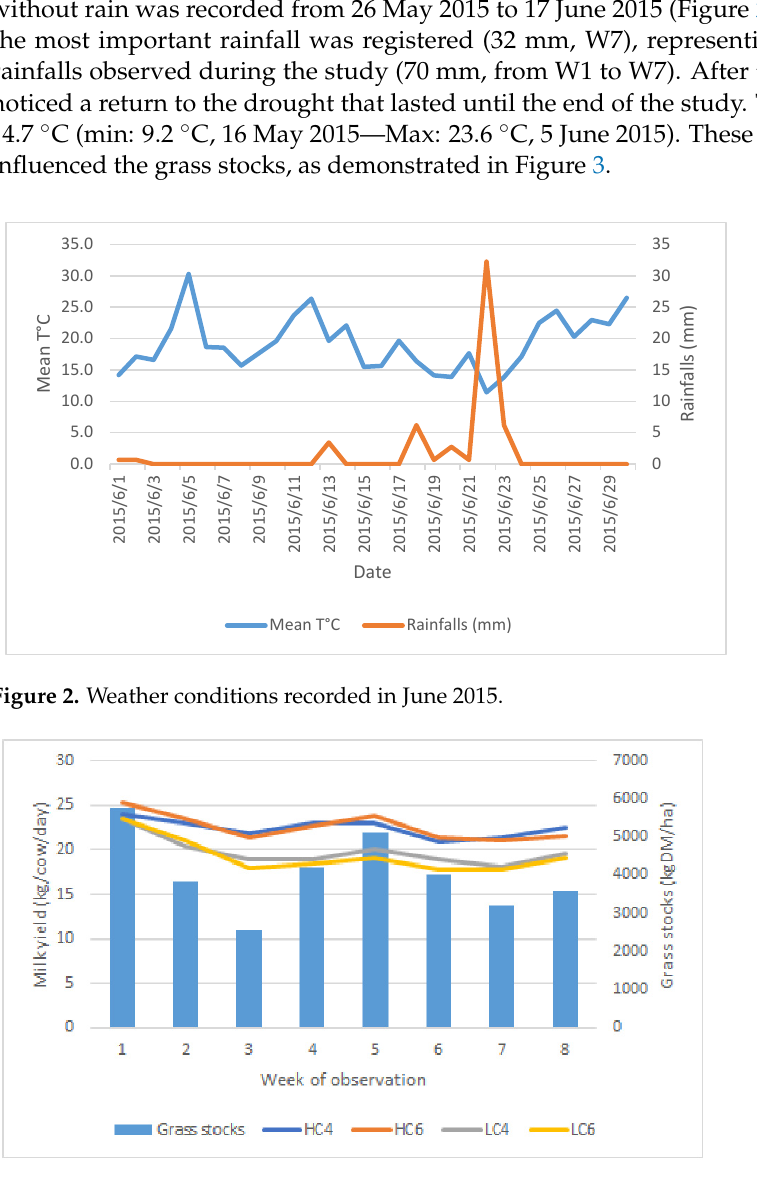
Figure 3. Evolution of milk yield over the observation weeks in the 4 groups in relation to the grass stock available (kgDM/ha) on the grazed paddock per week. Abbreviations. HC4, High concentrate allocation, minimum milking interval set at 4 h. HC6, High concentrate allocation, MMI set at 6 h. LC4, Low concentrate allocation, MMI set at 4 h. LC6, Low concentrate allocation, MMI set at 6 h. Table 2. Nutritional grass values.